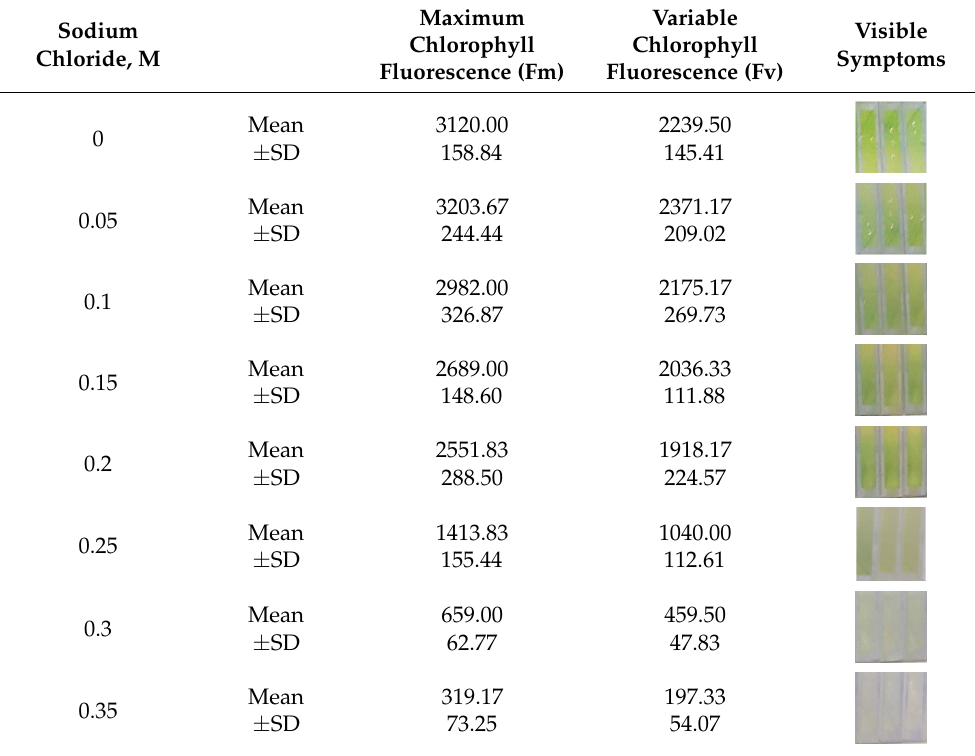
Table 4. The algae Pseudokirchneriella subcapitata exposed to 0–0.35 M of sodium chloride (NaCl) and the effect of sodium chloride (NaCl) on maximum chlorophyll fluorescence (Fm) and variable chlorophyll fluorescence (Fv) of plants. Data points represent the mean ± SD, n = 6.